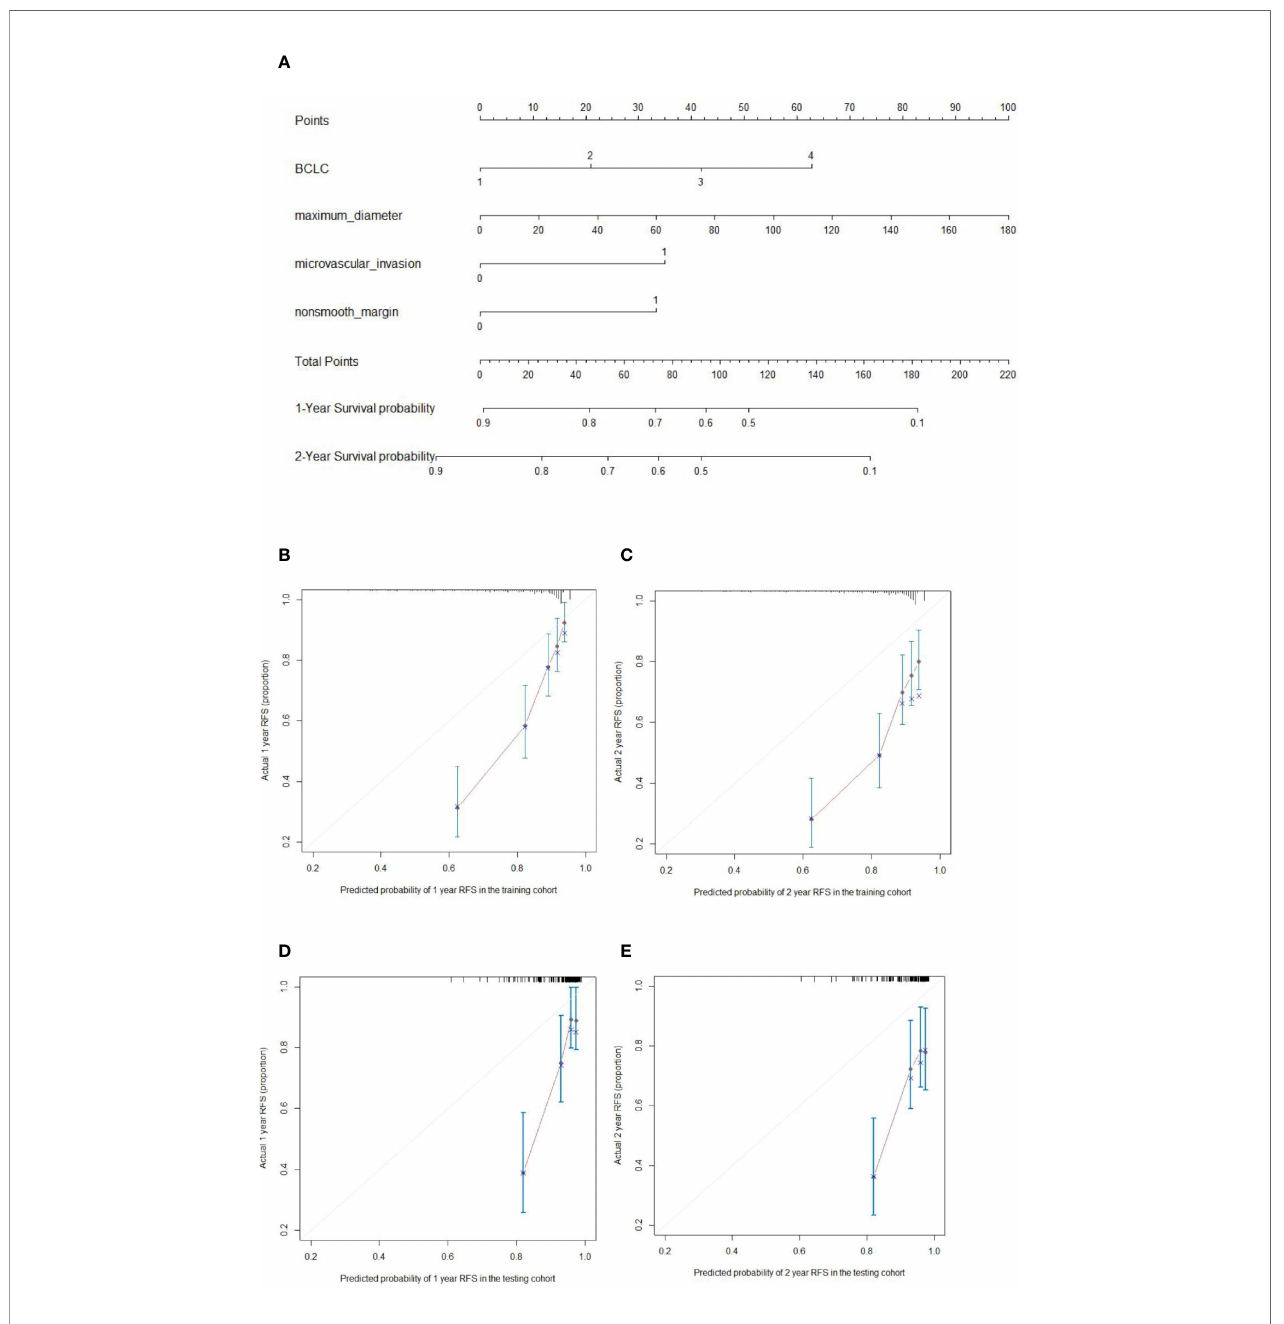
FIGURE 3 | Nomogram for predicting the recurrence-free survival (RFS) ( A ; 1, 2, 3, 4 on the BCLC scale represent BCLC 0 A B C respectively) and the calibration curves for predicting the 1- and 2-year RFS in the training cohort ( B, C , respectively) and testing cohort ( D, E , respectively) in hepatocellular carcinoma patients who underwent